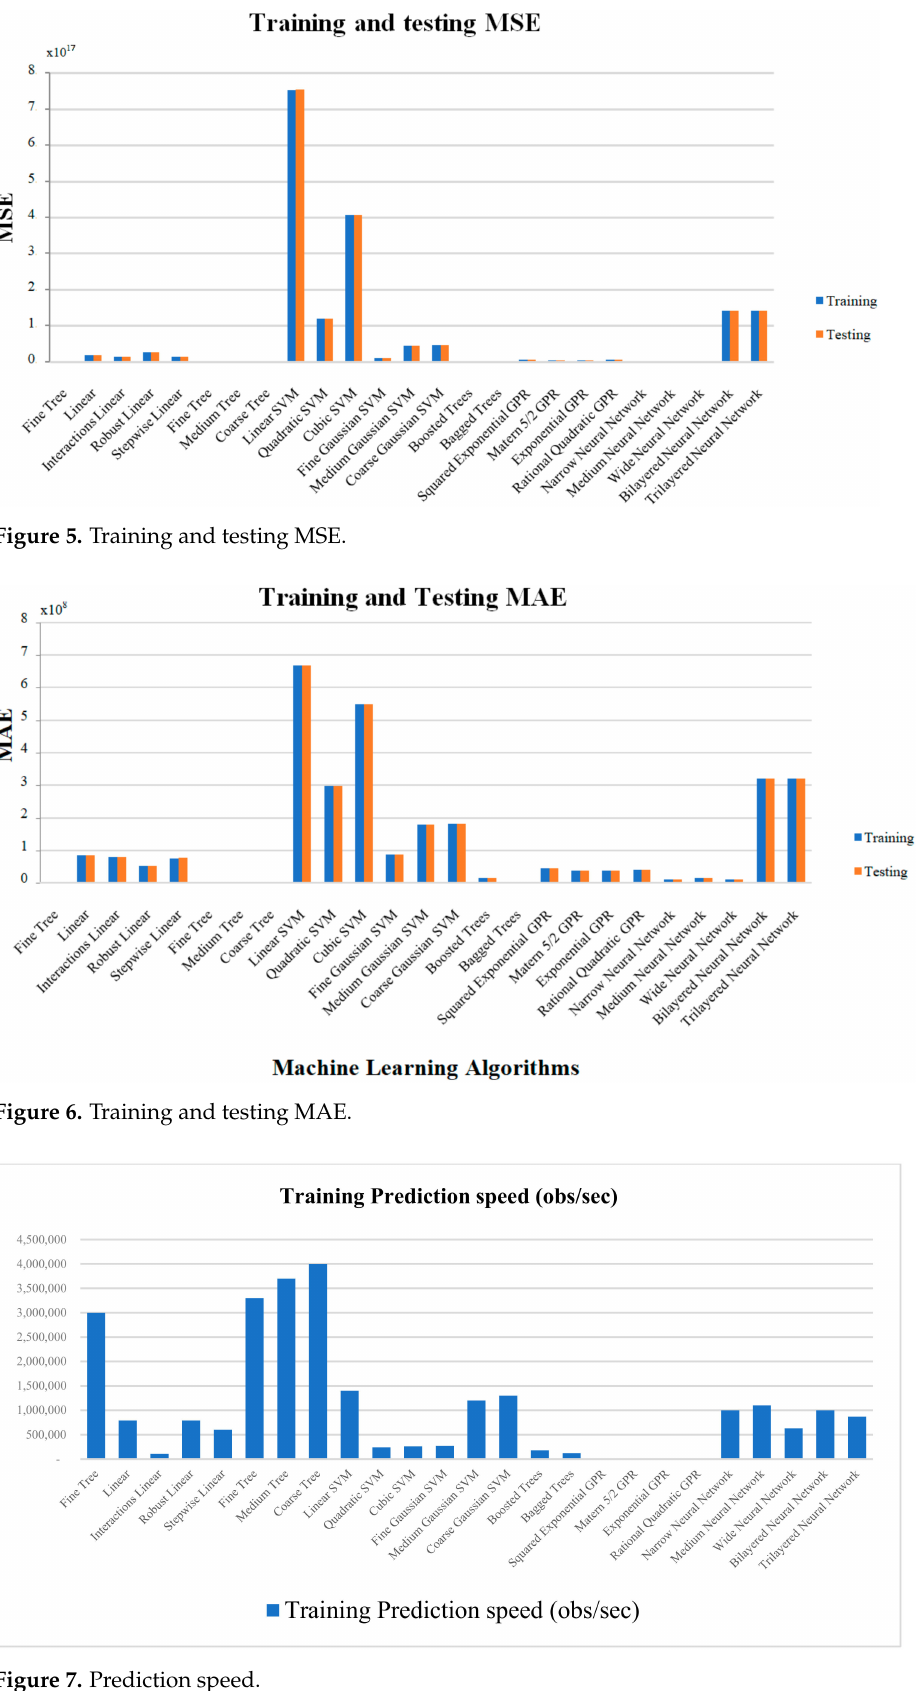
Figure 7. Prediction